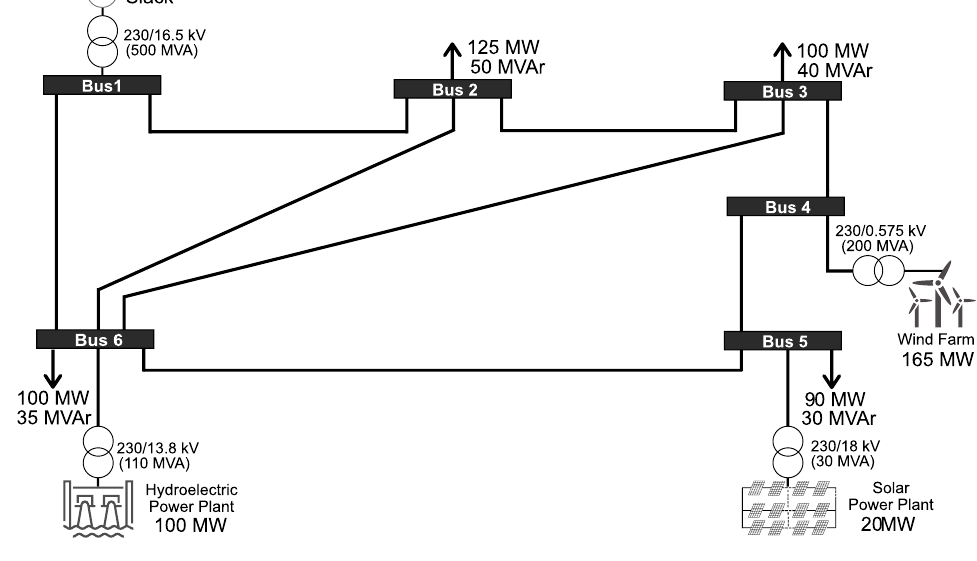
Figure 4. Single-line transmission system diagram.